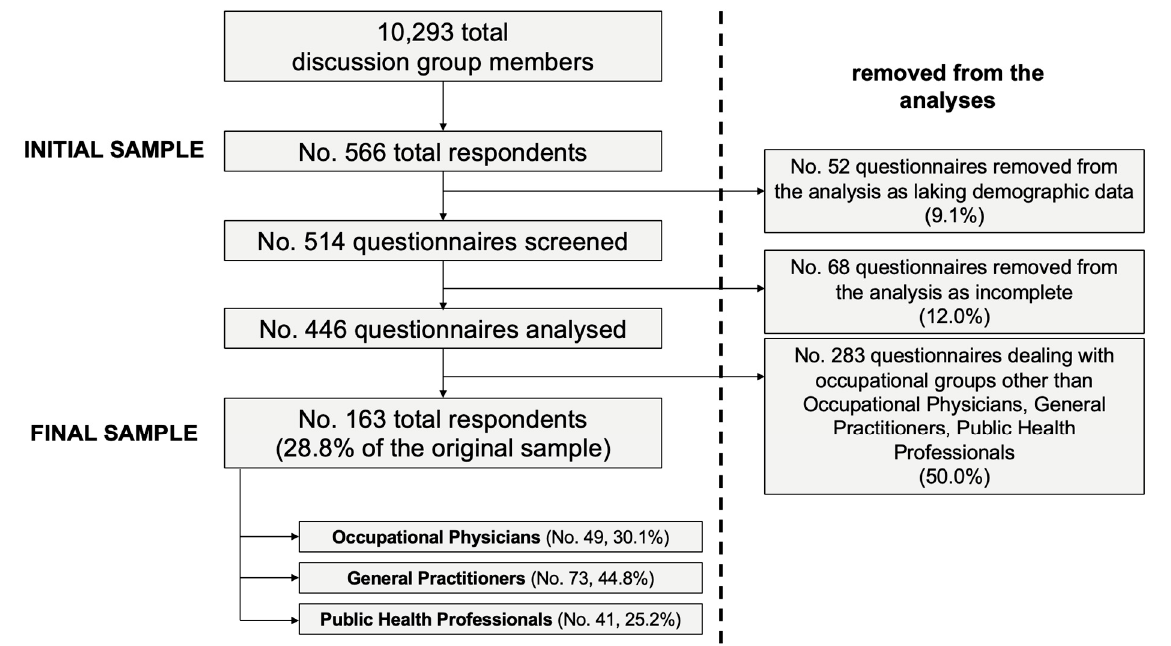
Figure 1. Flow char of the selection of study participants.